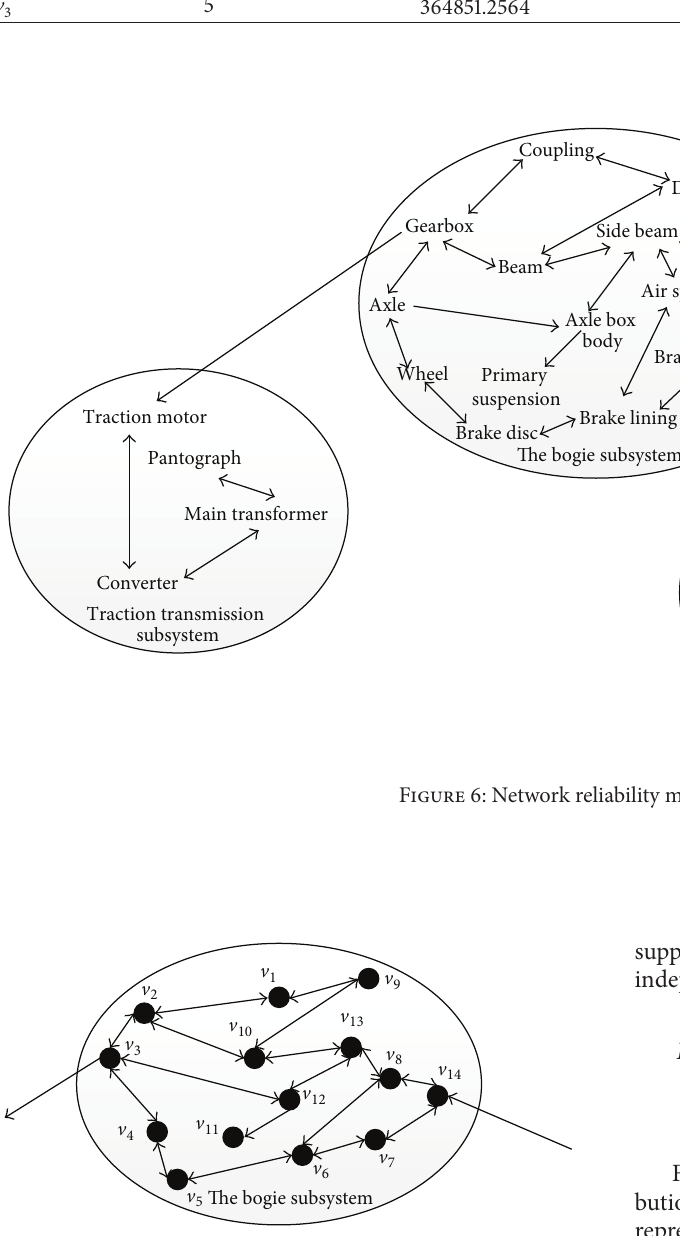
Figure 7: Reliability network model of bogie